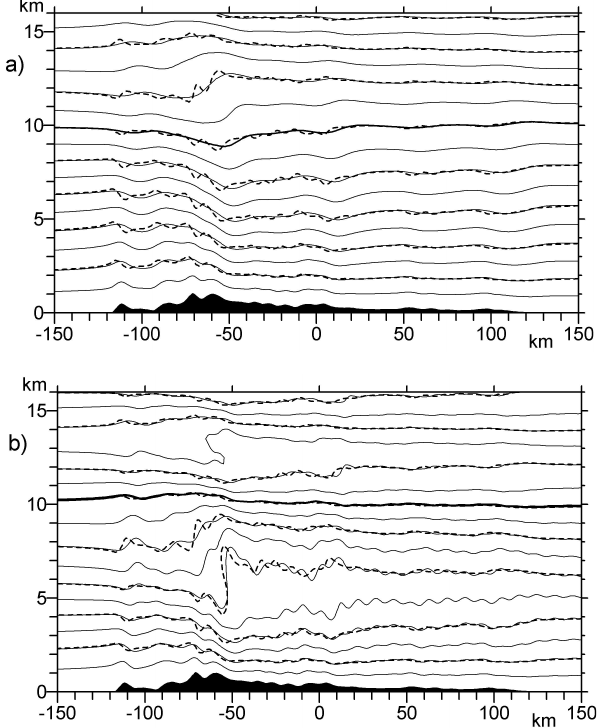
Fig. 6. Streamlines over the Scandinavian mountains, case b. No- tations are the same as in Figs. 5a–d. The flow fields (a) , (b) cor- respond to the points A, B in Fig. 3b. Flow is directed from left to right.